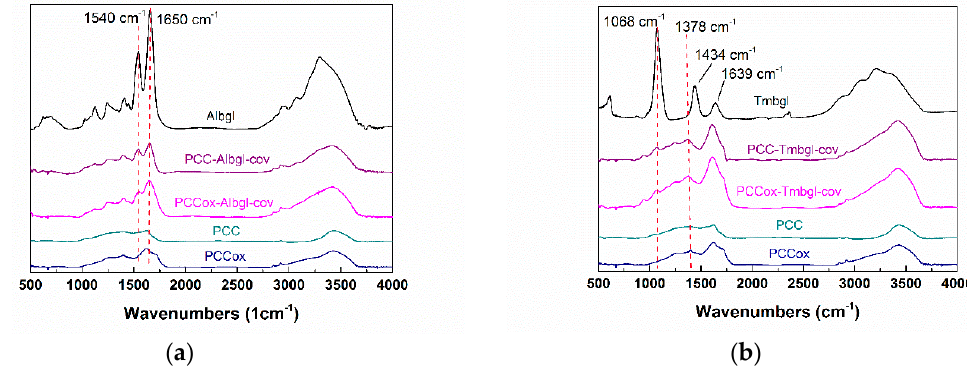
Figure 4. FTIR spectra of ( a ) PCC-Albgl-cov and PCCox-Albgl-cov compared to those of free Albgl and bulk PCC and PCCox. ( b ) PCC-Tmbgl-cov and PCCox-Tmbgl-cov compared to those of Tmbgl and bulk PCC and PCCox.